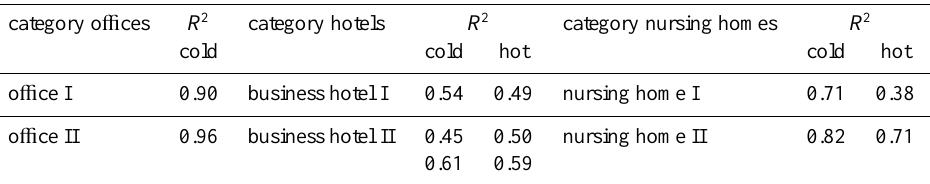
Table 8. Statistics of the comparison between measured and simulated water demands for o ffi ces, business hotels and nursing homes and their corresponding standardised